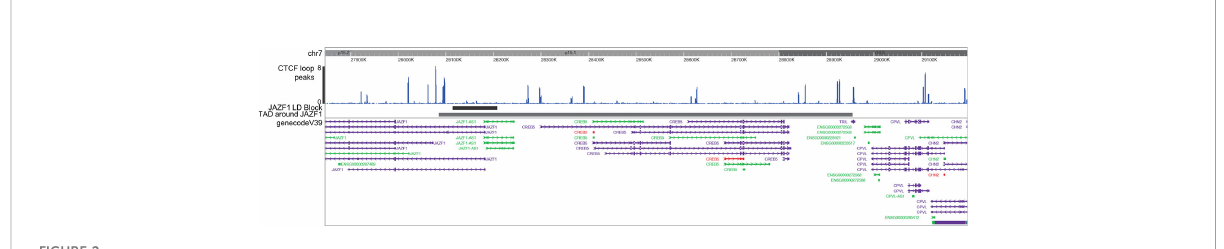
FIGURE 2 Washington University Epigenome Browser visualization of the JAZF1 risk locus (short solid bar), the corresponding TAD that surrounds the JAZF1 locus (longer solid bar) and, CTCF ChIPseq peaks (blue) and the genes located within the TAD. Note that each end of the TAD is anchored by